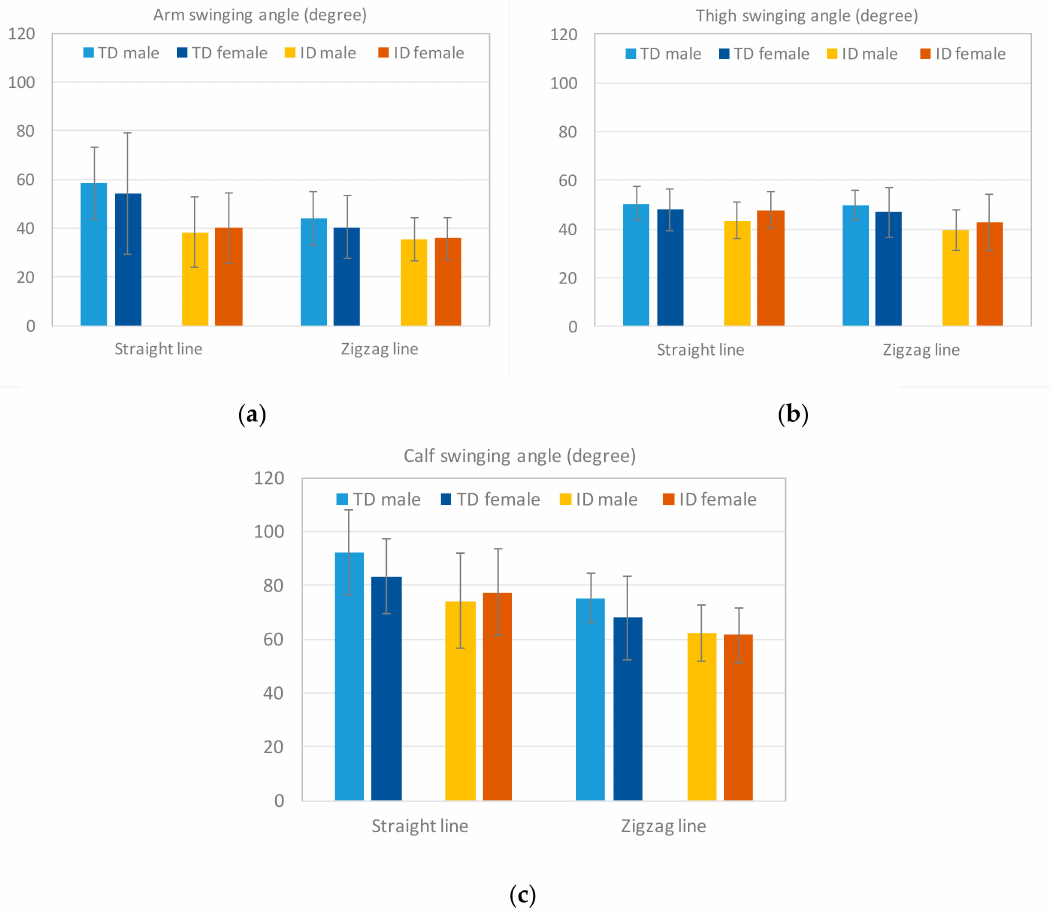
Figure 15. Results of the limb swinging angle: ( a ) A swing _ arm , ( b ) A swing _ thigh ,and ( c ) A swing _ calf .